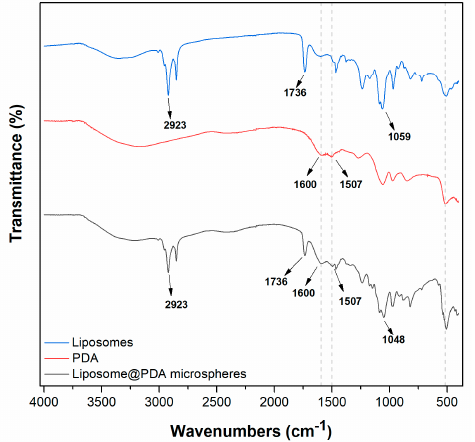
Figure 2. FTIR spectra of liposomes, PDA, and Liposome@PDA microspheres.